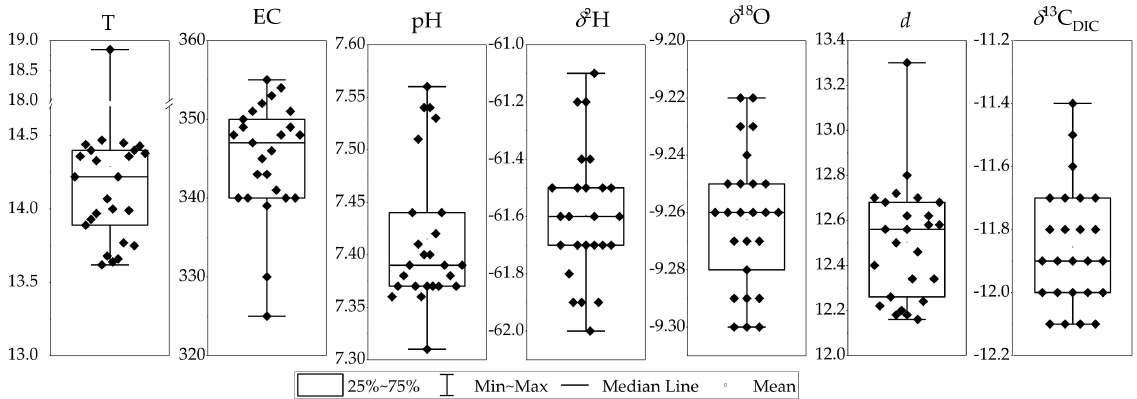
Figure 2. Boxplots of T [ ◦ C], EC [ µ S/cm], pH, δ 2 H [‰], δ 18 O [‰], d [‰], and δ 13 C DIC [‰] for all tap water samples.